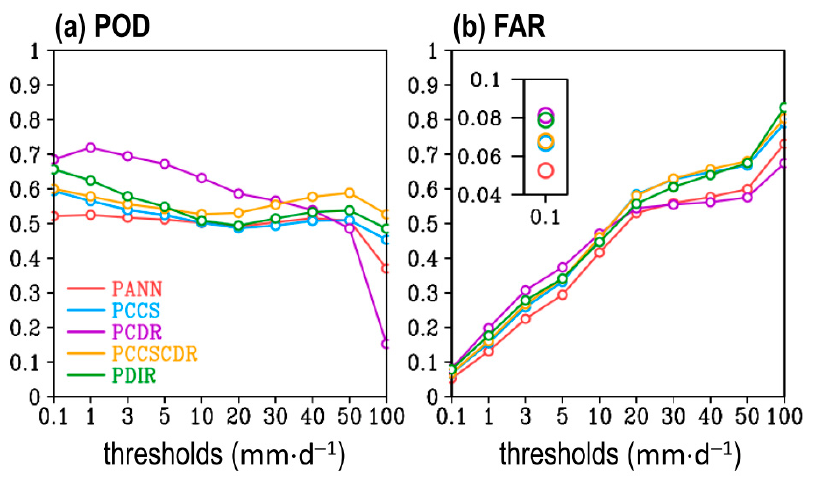
Figure 9. Statistical scores calculated for comparing daily precipitation grids that were extracted from Figure 8a between APHRO and five SPPs during 2003–2015 at different precipitation thresholds: ( a ) the probability of detection (POD); and ( b ) the false alarm ratio (FAR). In ( b ), the results for FAR at a 0.1 mm · d − 1 threshold are provided in the left top panel and